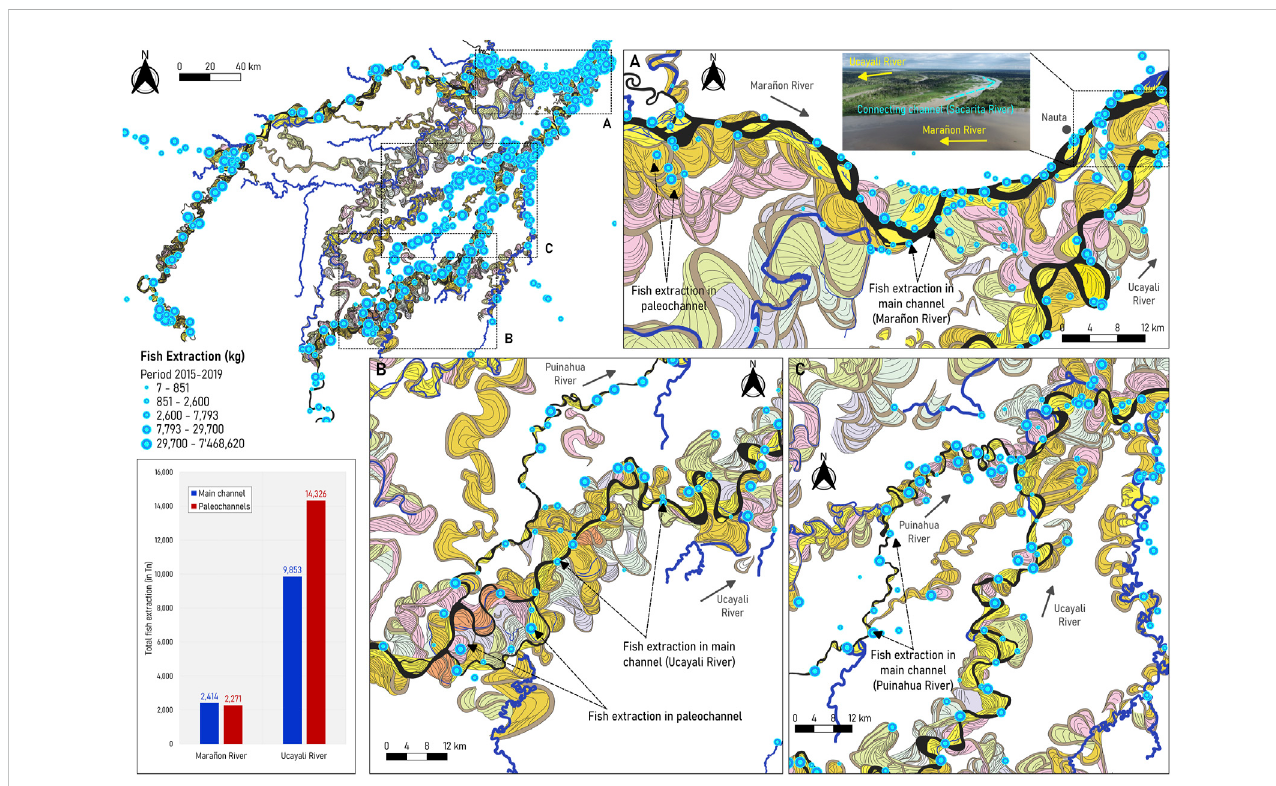
FIGURE 8 Modern and ancient river dynamics and fi sh production (photo courtesy of Senamhi-Loreto) (A) in the P-S wetland (reported by GOREL and WCS), (B) near the con fl uence of the Marañon and Ucayali Rivers, and (C) around the con fl uence of the Puinahua and Tapiche rivers with the Ucayali River. In (B) , the picture shows the connecting channel (sacarita), a connecting channel that is well-observed during the peak of the high- fl ow season (around May 2022). Fisheries data provided by Wildlife Conservation Society,